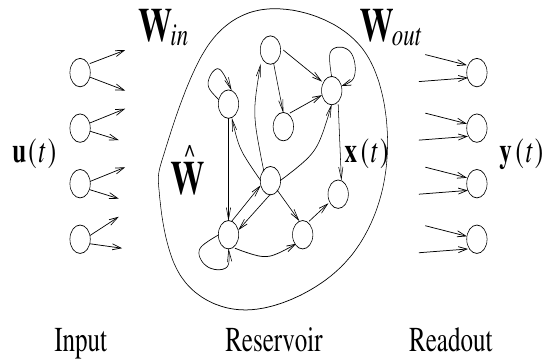
Figure 2. The architecture of an echo state network (ESN): W input, the reservoir and the output weights, respectively. The terms, u ( t ) and y ( t ) , identify the input at time t and the corresponding predicted read-out; x ( t ) is the associated reservoir state. Further details are given in the